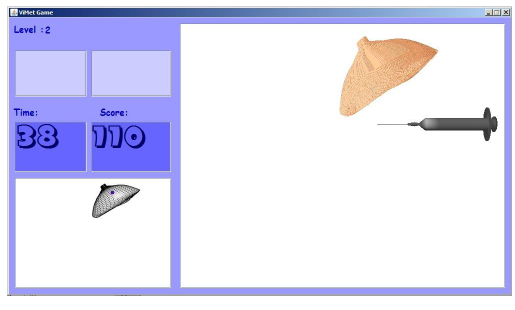
Figure 2. Example of the first phase of a ViMeTGame level.